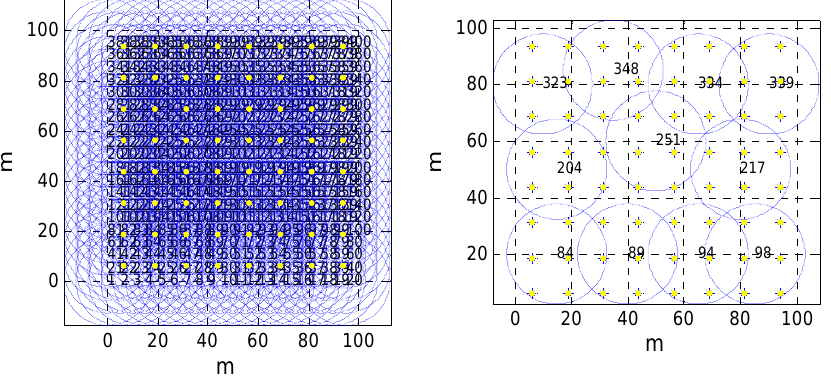
Figure 8. An illustration of uniform deployments of sensor nodes and POIs in the sample network and the simulation result after applying the CoCMA. The yellow star-shaped points represent POIs, and the blue circles represent the sensing ranges for nodes.